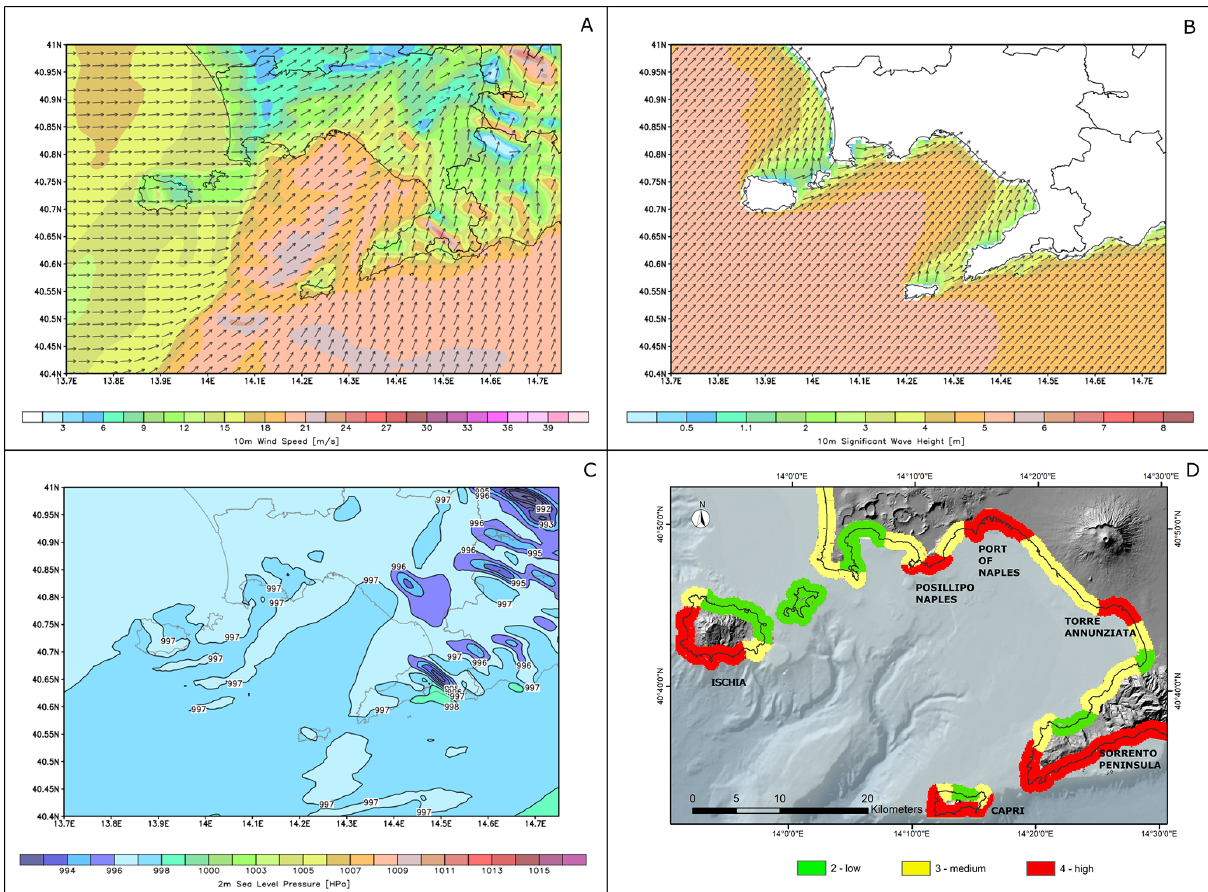
Figure 9. Maps during t max of (a) wind speed, (b) significant wave height, (c) sea level pressure, (d) the cumulative effect of the three modeled parameters. The DTM of the emerged area was downloaded from ISPRA webGIS (http://www.sinanet.isprambiente.it, last access: 1 February 2021); the DTM of the emerged area was downloaded from the GEBCO website (http://www.gebco.net/data_and_products/ gridded_bathymetry_data, last access: 1 February